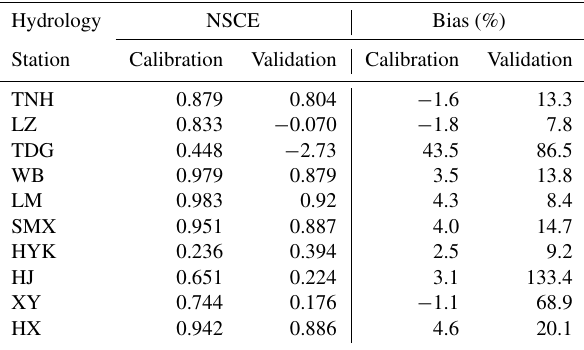
Table 3. The statistics of calibration and validation periods monthly flows for the ten sub-catchments in YRB.